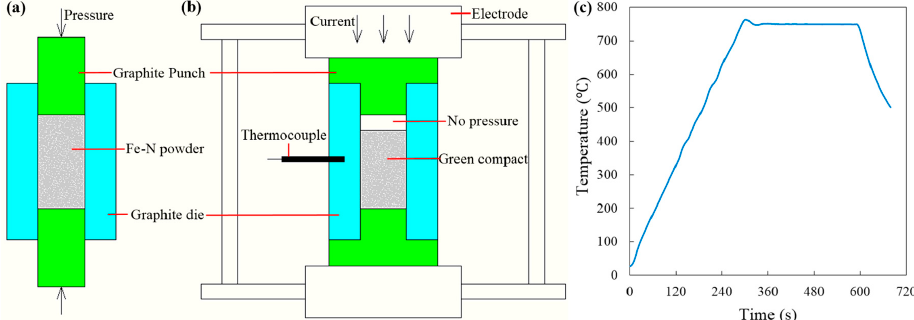
Figure 4. Schematics of the preparation process of porous iron. ( a ) Pre-compaction; ( b ) pressureless SPS process; ( c ) temperature profile used in the pressureless SPS process. SPS process; ( c ) temperature profile used in the pressureless SPS